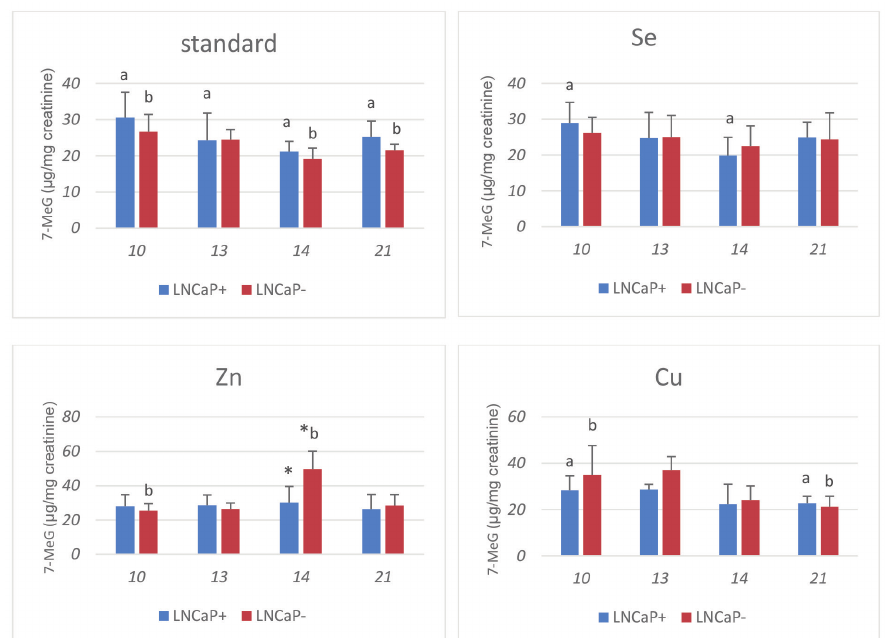
Figure 2: The effect of Se, Zn and Cu supplementation on the excretion of urinary 7- methylguanine (μg/mg creatinine) (10-13-14-21 week) in rats treated and non-treated with prostate cancer cells. a – groups implanted cancer cells; group fed standard diet versus groups fed diet with addition of trace elements (p≤0.05). b – groups non-implanted cancer cells; group fed standard diet versus groups fed diet with addition of trace elements (p≤0.05). * - implanted versus non-implanted cancer cells rats